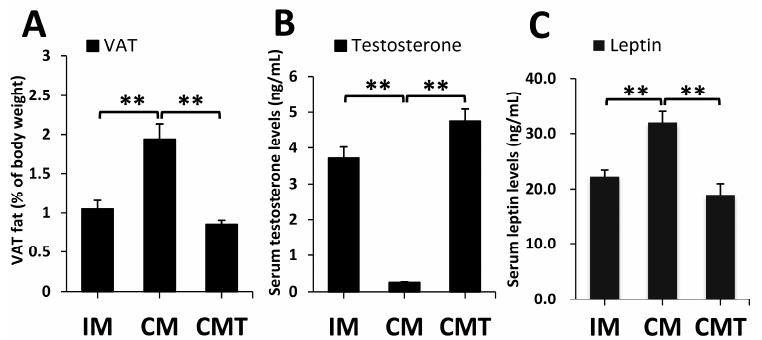
Figure 1. Effects of castration and testosterone treatment on visceral adipose tissue (VAT) fat, serum testosterone and leptin levels: ( A ) VAT fat percentage of body weight; ( B ) serum testosterone levels; and ( C ) leptin levels. IM: intact male pigs fed a high-fat and high-cholesterol (HFC) diet; CM: castrated male pigs fed a HFC diet; CMT: castrated pigs with testosterone replacement fed a HFC diet. Data were represented as means ± SEMs, n = 4 per group. ** p < 0.01. Table 1. Statistics of the sequencing reads mapping to the reference Sscrofa 10.2 genome.